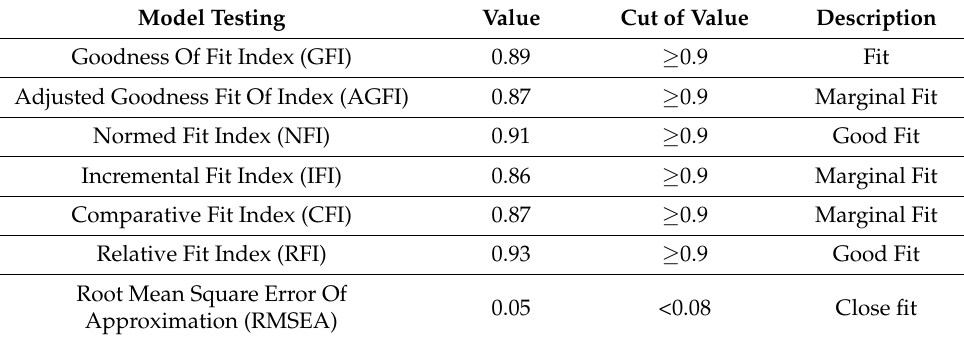
Table 9. Fit Model